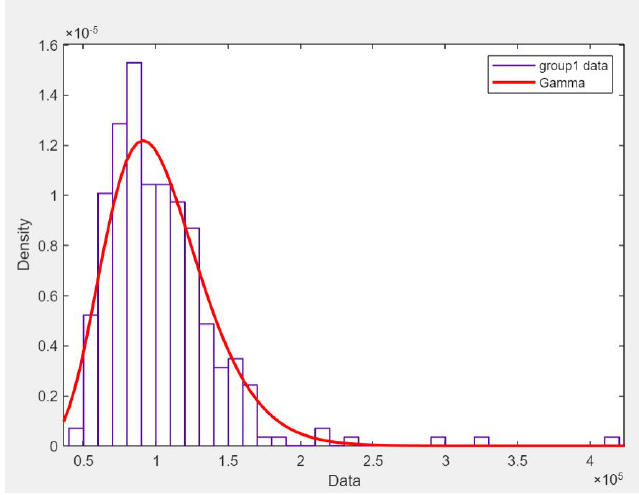
Figure 10. HISTFIT for group 1 in Category